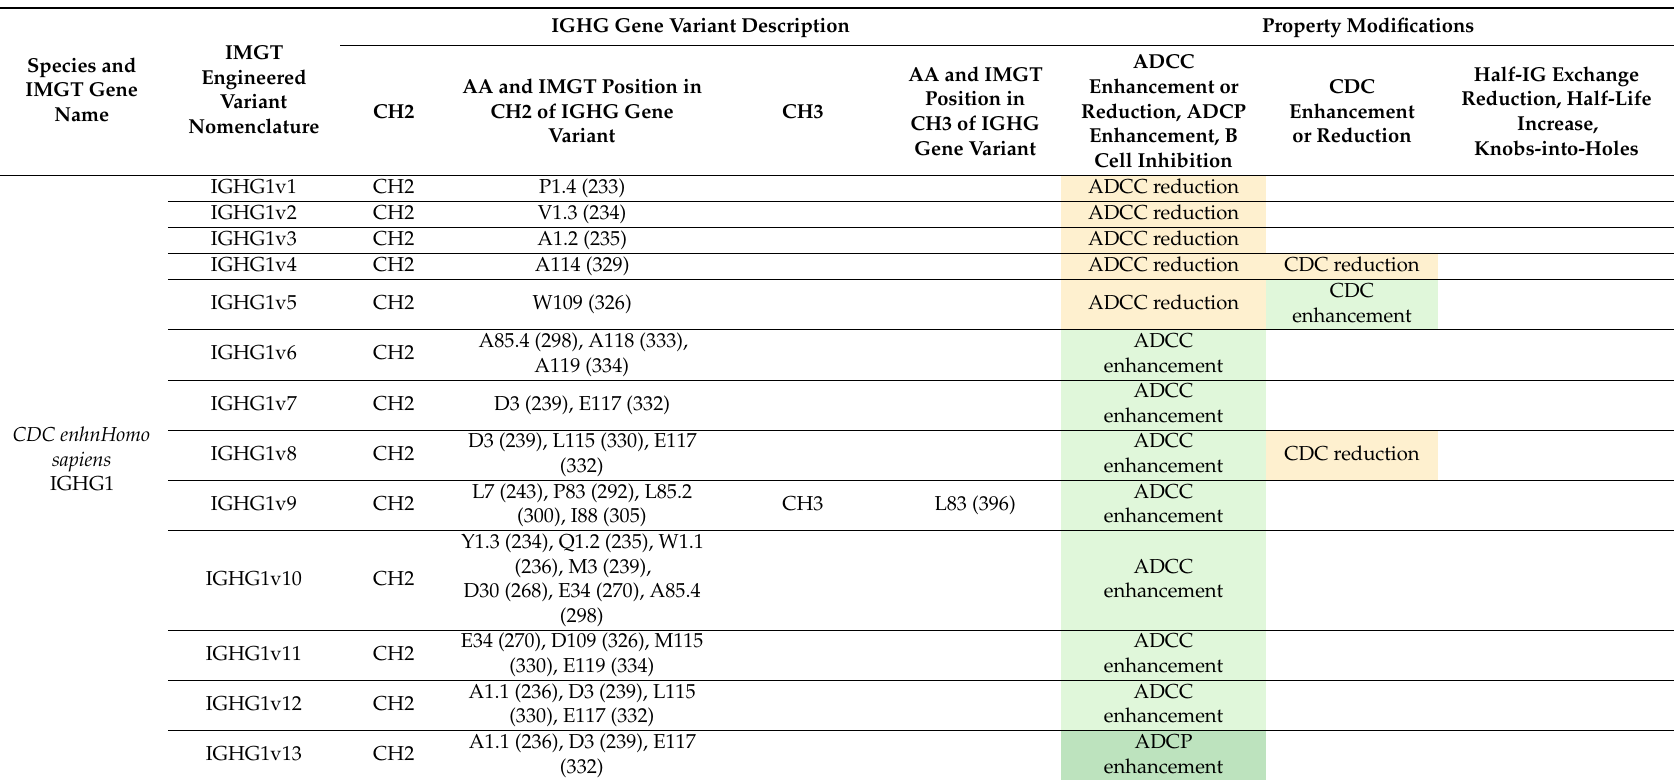
Table 15. IMGT engineered variant nomenclature [311]. Homo sapiens IGHG variants involved in ADCC, ADCP, CDC, half life increase, half-IG exchange, B cell inhibition, and knobs-into-holes are shown. In mAb description, the Eu numbering between parentheses is replaced by the amino position in the antibody gamma chain. Amino acid changes and bibliographical references are quoted at The IMGT Biotechnology page (IMGT ® http: // www.imgt.org The IMGT Biotechnology page > Amino acid positions involved in ADCC, ADCP, CDC, half-life and half-IG exchange). Properties modifications include: ADCC or CDC enhancement (pale green), ADCP enhancement (dark green), ADCC or CDC reduction (pale orange), B cell inhibition (orange), Half-life increase (pale blue), Hald-IG exchange reduction, Hole or Knob in knobs-into-holes interaction, Favors hexamerisation, Site-specific drug attachment, No N-glycosylation site, No disulfide bridge inter H-L